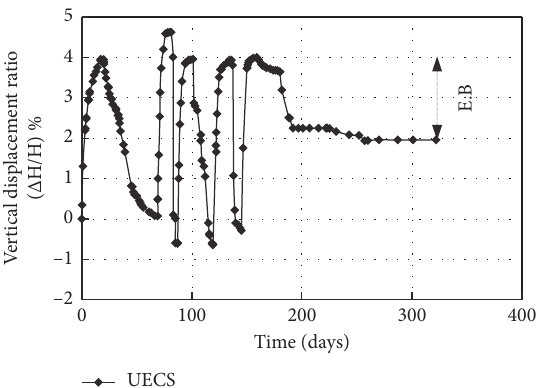
Figure 4: Vertical displacement ratio versus time during wetting and drying cycles.